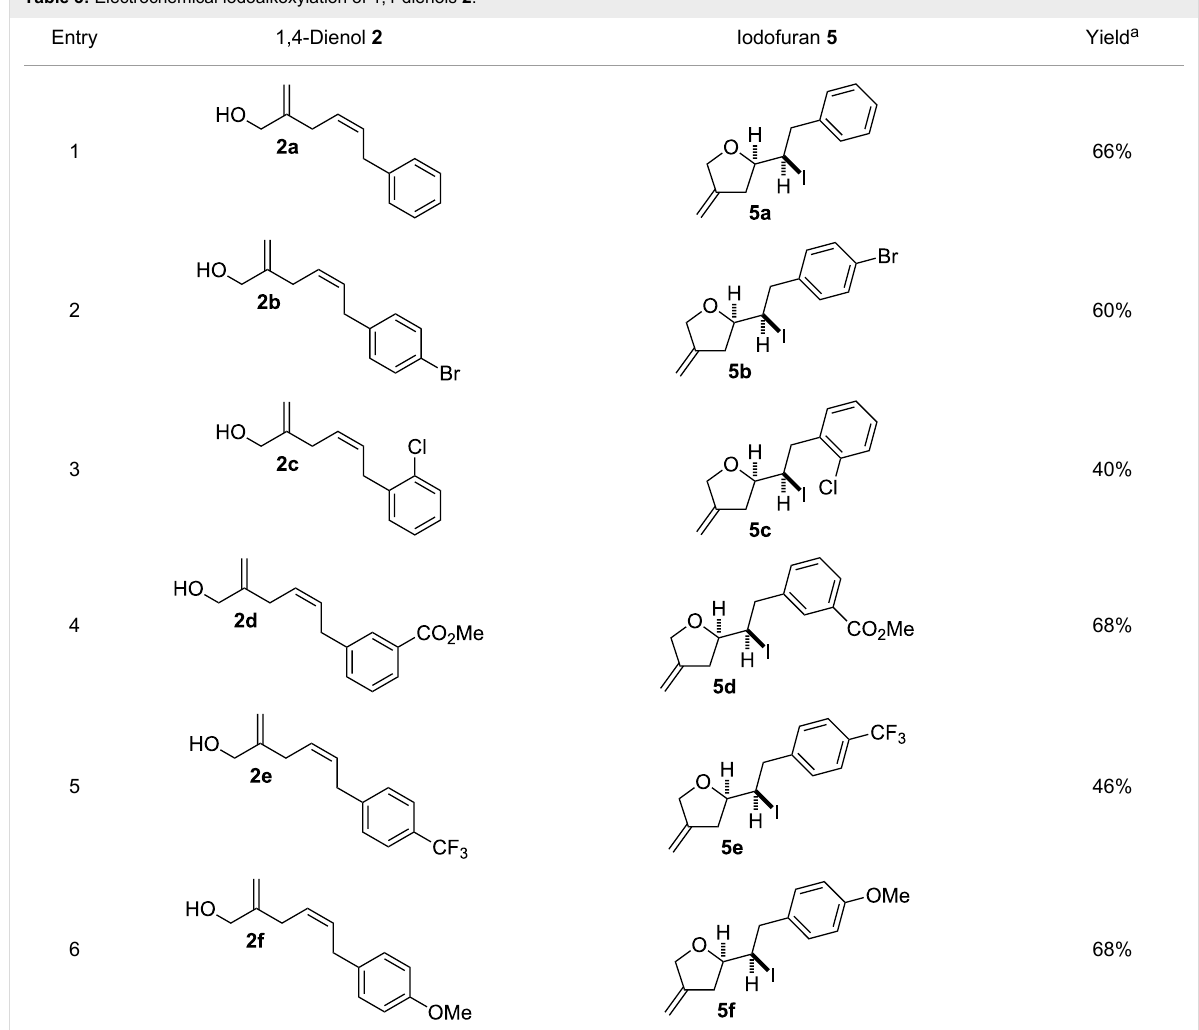
Table 3: Electrochemical iodoalkoxylation of 1,4-dienols 2 . Entry